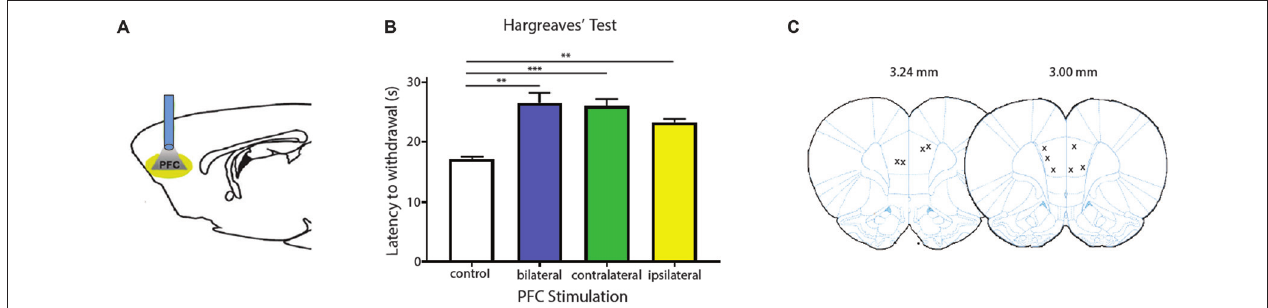
FIGURE 2 | Activation of PL-PFC neurons relieves acute pain. (A) Schematic showing the optogenetic strategy to activate PL-PFC neurons. (B) Bilateral ( n = 5, p = 0.0064), contralateral ( n = 5, p = 0.0008) and ipsilateral ( n = 5, p = 0.0041) activation of PFC neurons caused an increase in the latency to paw withdrawal during Hargreaves’ test when compared to control ( n = 5). Two-tailed paired Student’s t test. Error bars show mean and SEM. (C) Diagram showing the locations of optic fibers in the